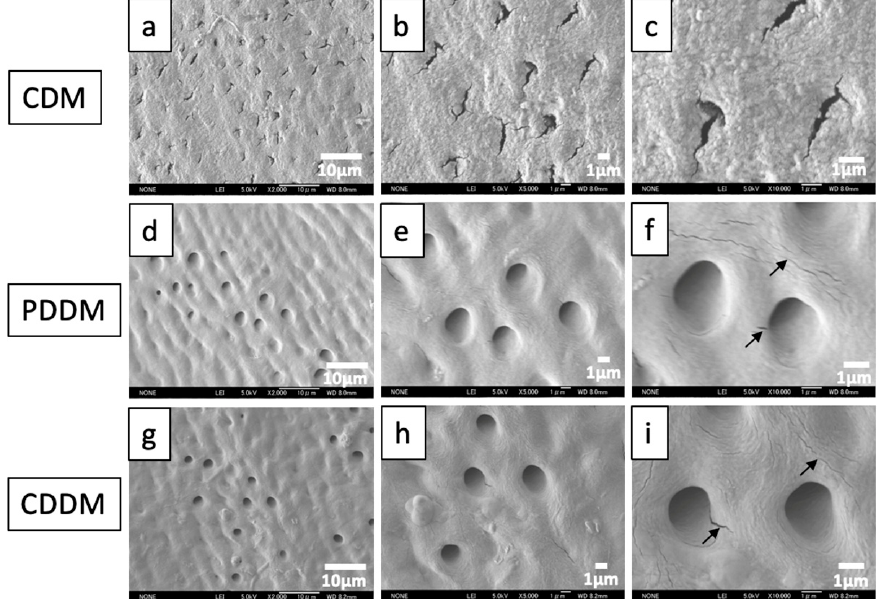
Figure 3. FE ‐ SEM photographs of CDM ( a – c ), PDDM ( d – f ) and CDDM ( g – i ). ( a – c ) CDM: Mineralized dentin with irregular surface. Almost closed dentinal tubes affected by machine cutting. ( d – f ) PDDM: Opening of dentinal tubes and smooth surface. Micro ‐ cracks (arrows). ( g – i ) CDDM: Opening of dentinal tubes and smooth surface. Micro-cracks (arrows). CDM: Calcified dentin matrix, PDDM: Partially demineralized dentin matrix, CDDM: Completely demineralized dentin